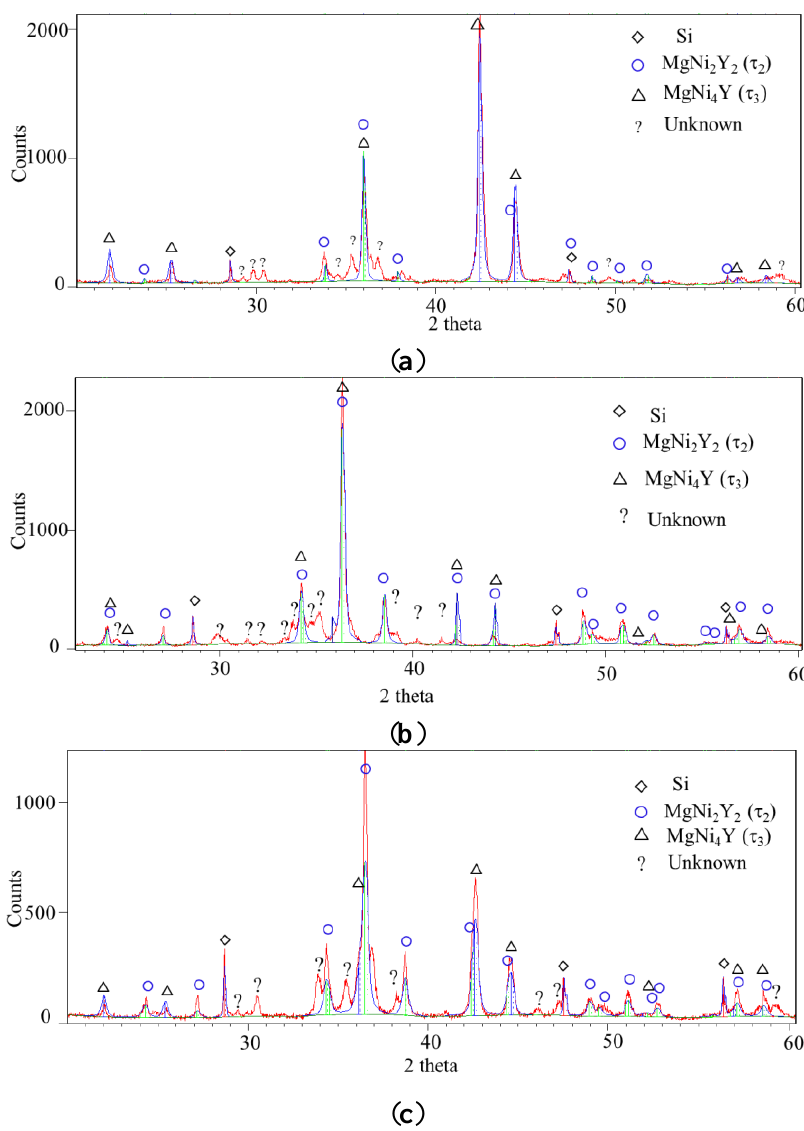
Figure 16. XRD patterns for ( a ) Sample 10 (20.0/50.8/29.2 Mg/Ni/Y at%); ( b ) Sample 11 (26.0/38.2/35.8 Mg/Ni/Y at%); ( c ) sample 12 (28.0/36.8/35.2 Mg/Ni/Y at%).